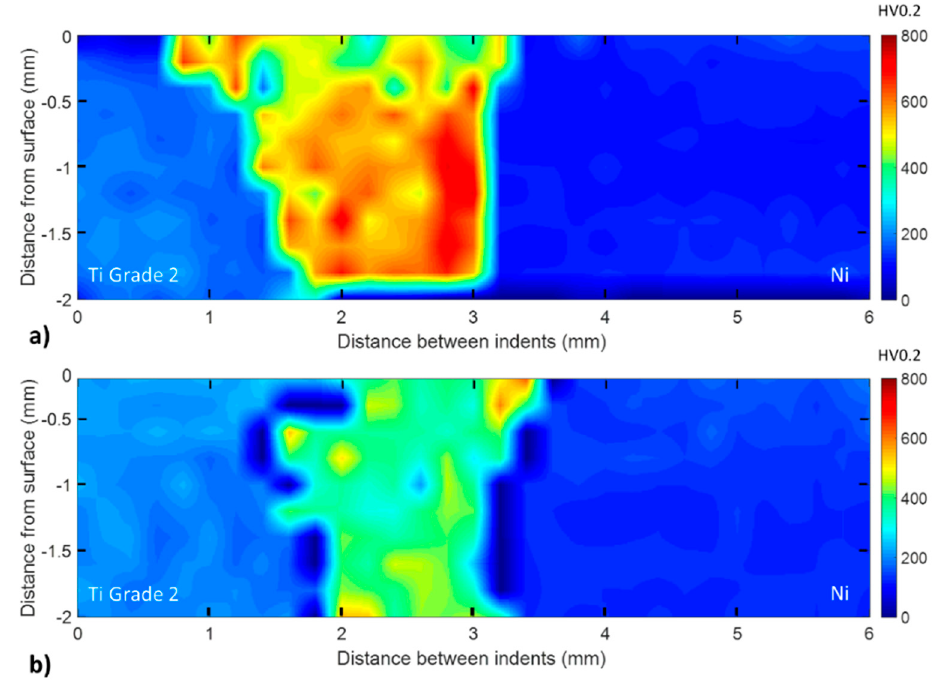
Figure 13. Microhardness map of weld joints 8 ( a ) and 10 ( b ) produced with various heat